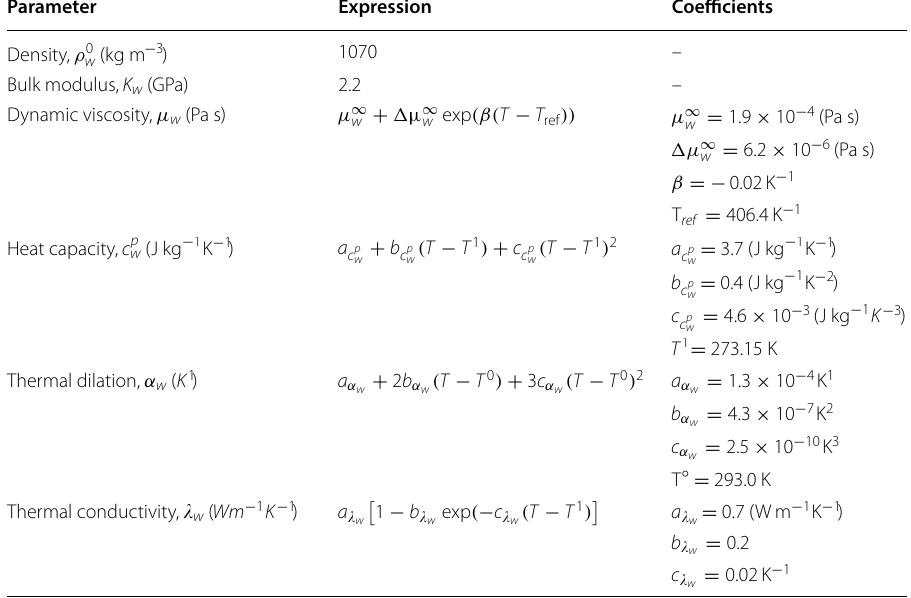
Table 2 Review of the constitutive equations of the brine properties and values of empirical coefficients